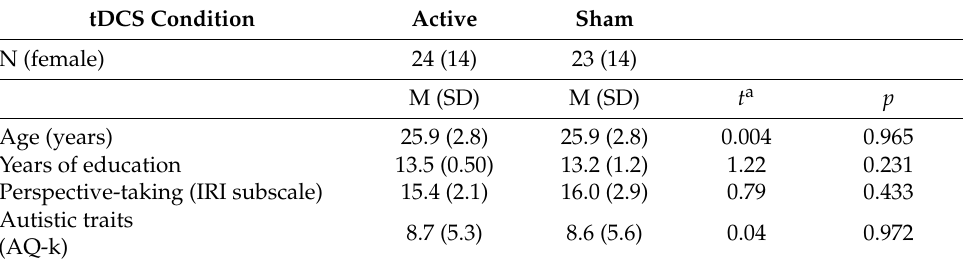
Table 2. Demographics and individual